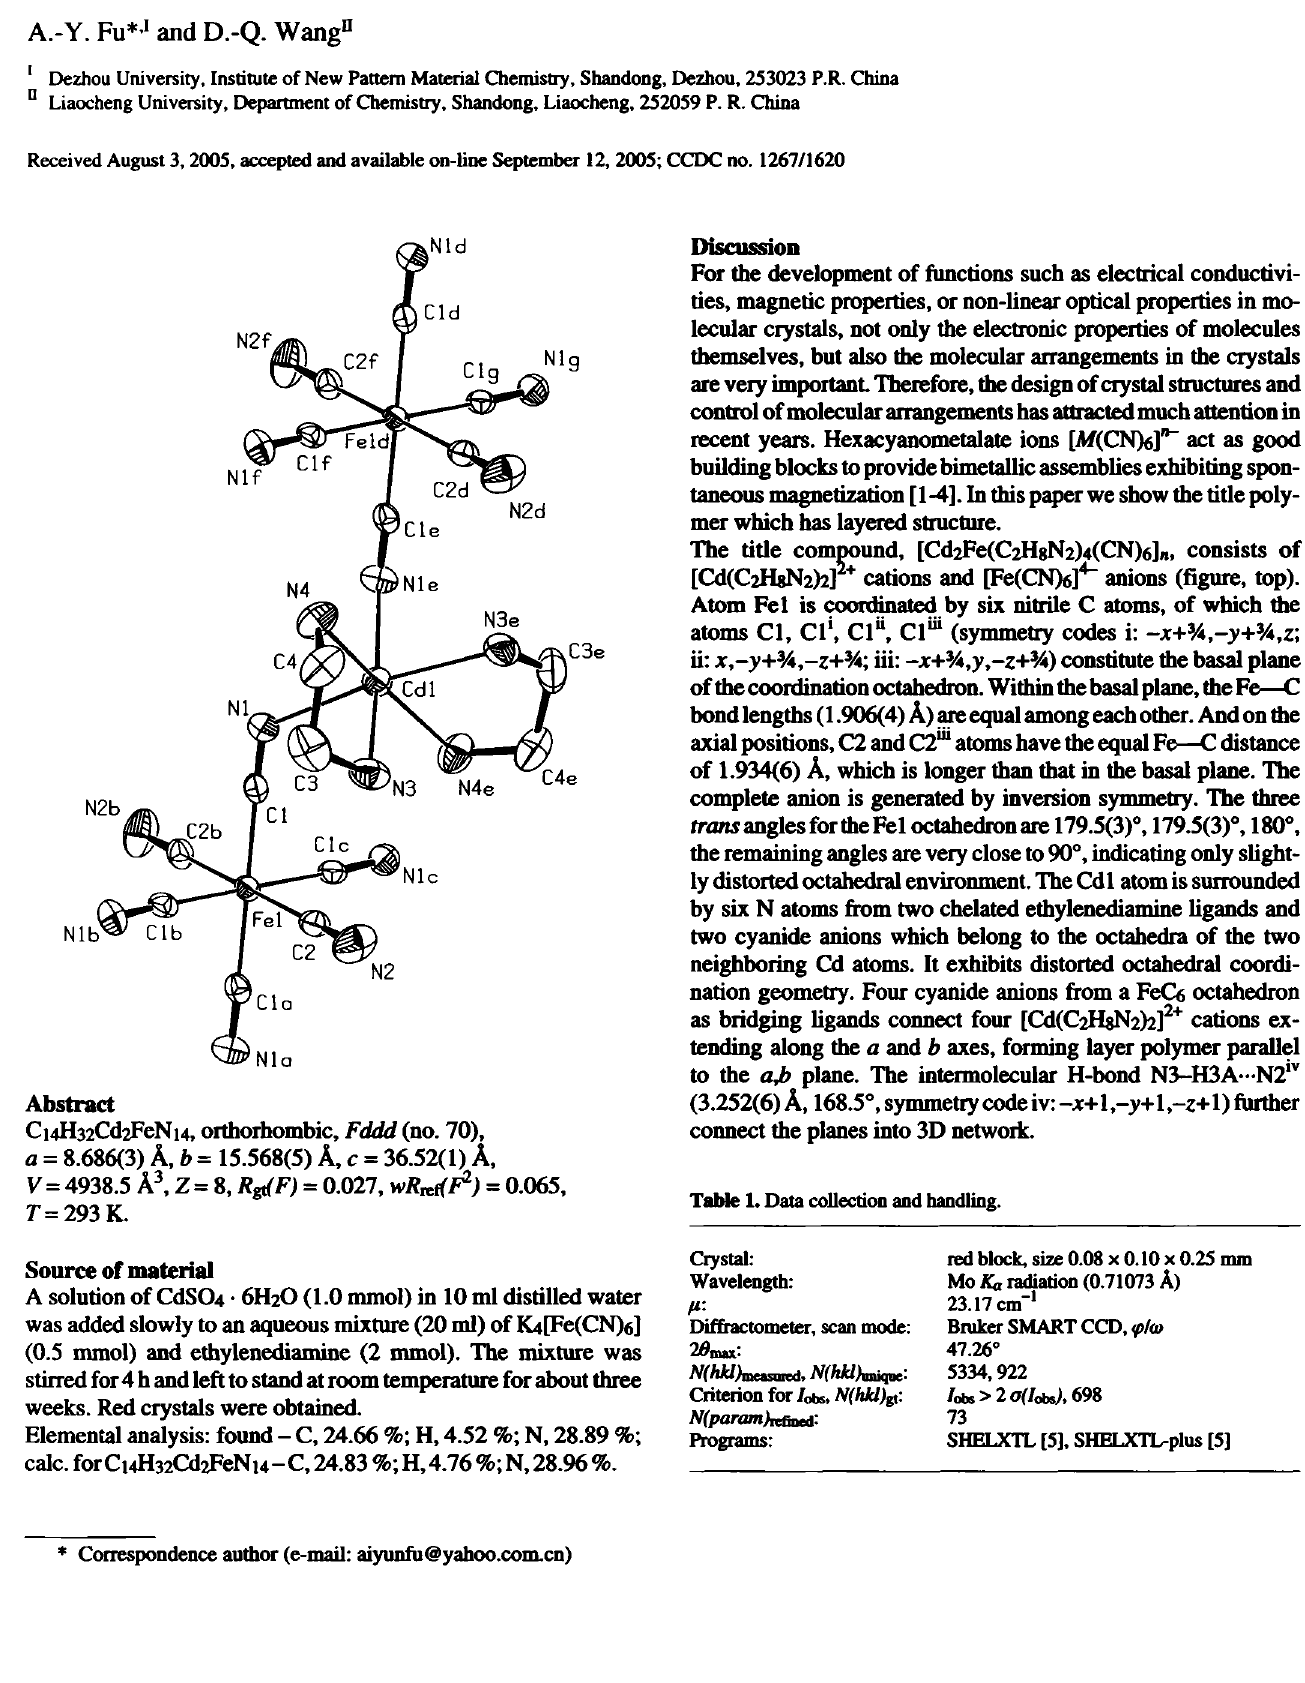
Table 1. Data collection and